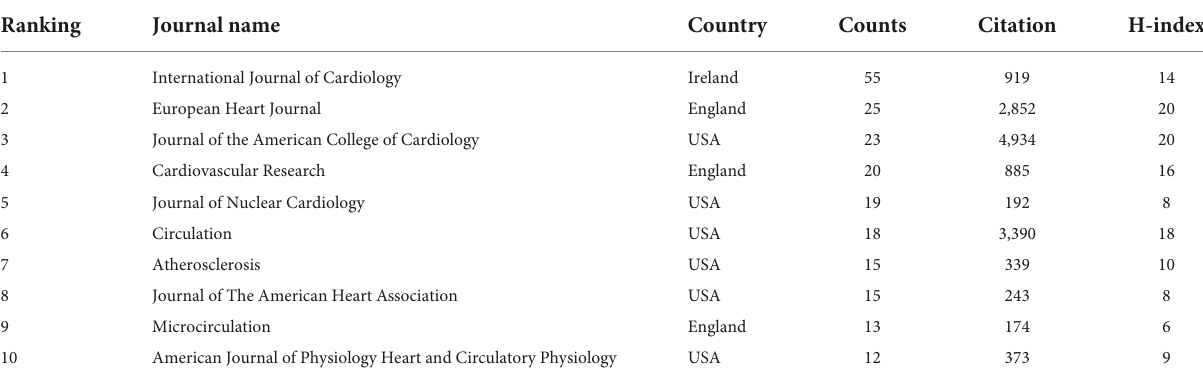
TABLE 2 Ranking of the top 10 journals based on